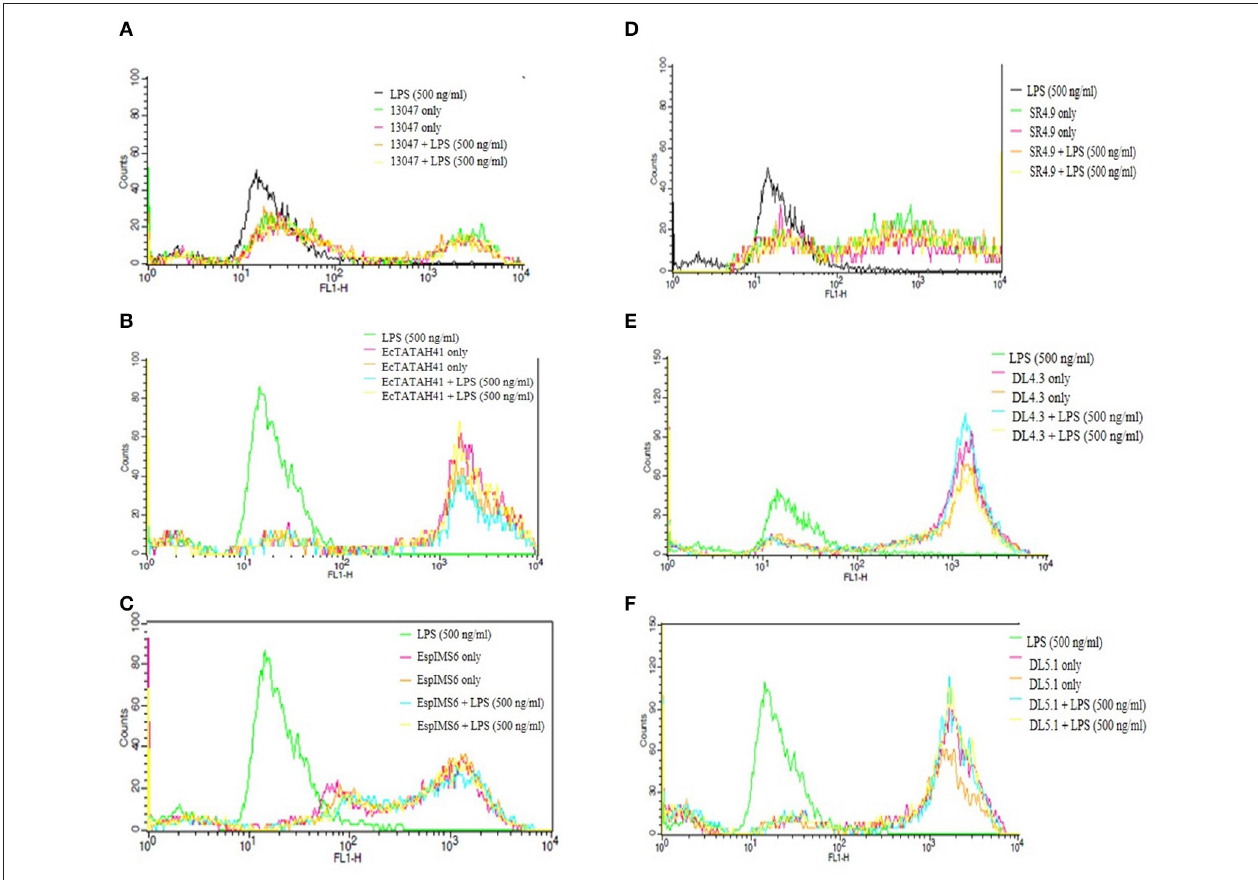
FIGURE 4 | Determination of ROS generation in neutrophils challenged with MDR Enterobacter isolates. The histograms of Dihydrorhodamine 123 fluorescence emitted due to activation of neutrophils by the MDR pathogens with and without LPS (in duplicate) and LPS control were recorded and represented here with gated populations for clinical E. cloacae ATCC 13047 (A) , EcTATAH41 (B) and EspIMS6 (C) and environmental SR4.9 (D) , DL4.3 (E) , DL5.1 (F) Enterobacter